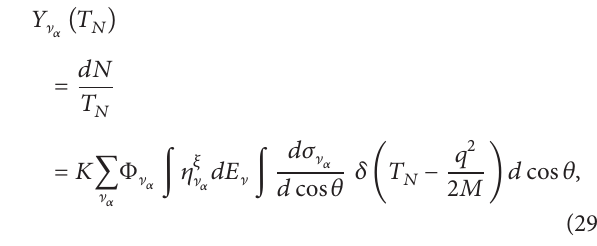
Figure 3: Total coherent cross sections 𝜎 ] the SM neutrino processes ] 𝛼 (̃ ] 𝛼 ) + (𝐴, 𝑍) → ] 𝛼 (̃ ] 𝛼 ) + (𝐴,𝑍) .